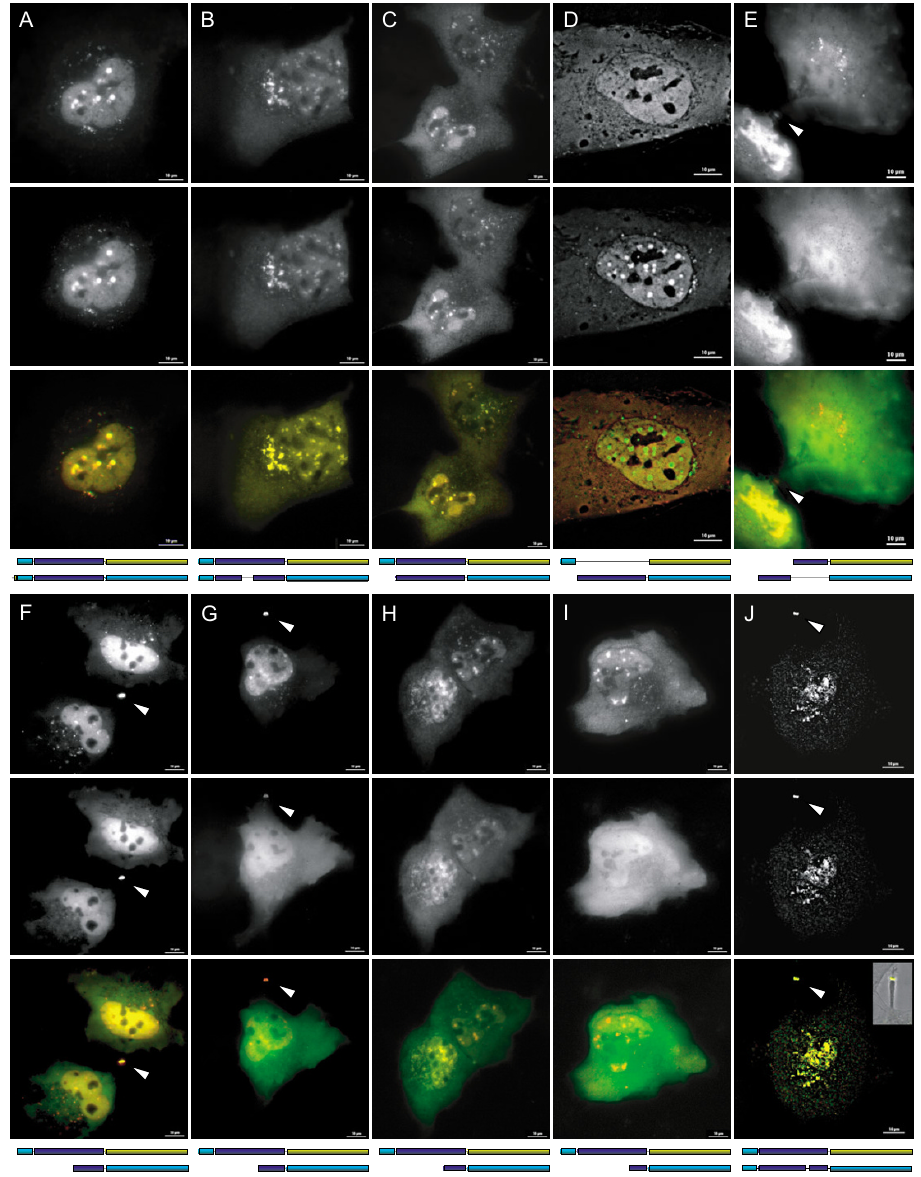
Figure 7 Localization of mutated CB-FP chimaeras in transiently expressing LCLC-103H cells . Individual expression with corresponding constructs (above: EYFP-tagged; below: ECFP-tagged) and false colour superposition of both fluorescence chan- nels (YFP: red; CFP: green) are shown. Double-transfection of ∆ 72 CB (A) or CB([C211_I243del]SC) (B) with CB(SC), respec- tively, resulted in a complete colocalization of both constructs. The heavy chain domain still colocalized with the single form to a large extent (C). Compared with the heavy chain, the light chain of CB was distributed homogeneously throughout the cell as pure GFP (D). In contrast to the CB(HC ) constructs, CB(HC ) expressed hotspots around the Golgi and inside the nucleus N' C' and stained the midbody (E). Transient coexpression of CB(SC) and its increasingly truncated C-terminal fragments (F-J) revealed decreased nuclear fluorescence with smaller fragment size. Already in case of CB(HC ) (F), the tendency to accumu- C'1 late was reduced considerably and the accumulations disappeared completely in case of CB(HC ) transfection (I). The latter C'4 showed an almost complete homogeneous signal distribution without any accumulation in the nucleus, the granules, or the midbody, respectively. The elimination of 9 residues in the C-terminal part of CB (Q268_G277del) had no significant influence on the localization; the construct still colocalized completely with CB(SC) (J; the inset is a superposition of the midbody fluo- rescence with the corresponding phase contrast image). A-C, G-I. OPM; λ (ECFP): 430 nm; λ (EYFP): 500 nm; obj. 60×/1.2 Ex. Ex. Plan Apo water. D-F, J. WFM, in part after deconvolution (D, J); obj. 63×/1.25 Oil (D, F, J); obj. 40×/0.60 (E); bars 10 µ